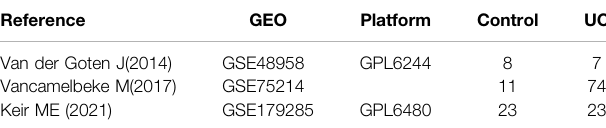
TABLE 1 | Details for GEO UC data.